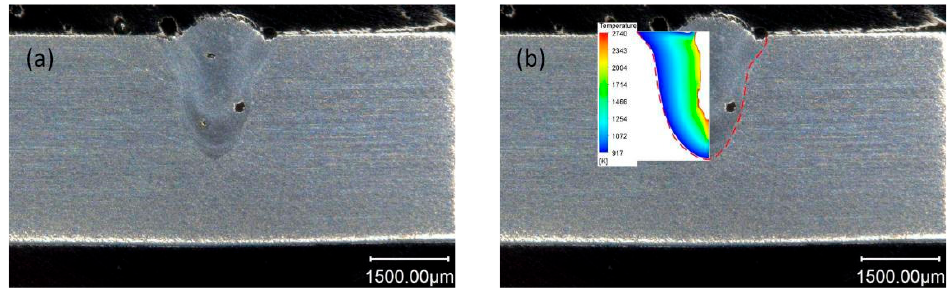
Figure 2. Comparison of the experimental weld seam with the simulated molten pool. ( a ) the experimental weld seam cross section at a welding speed of 3 m/min; ( b )the simulated molten pool at a welding speed of 3 m/min.